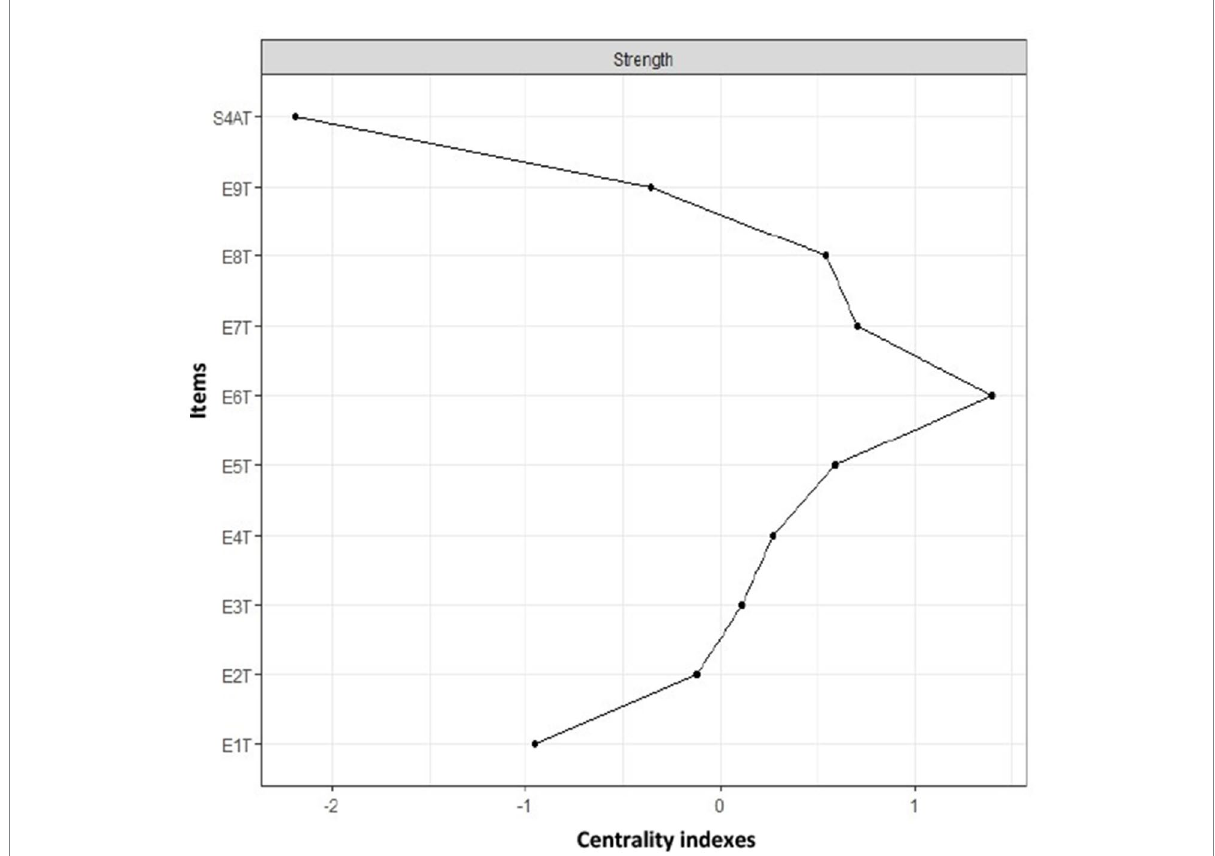
FIGURE 2 Network analysis strength centrality indexes of network analysis. Centrality refers to the measure with the highest number of connections along with the sum of the relationships it presents. T1: type 1; T2: type 2; T3: type 3; T4: type 4; T5: type 5; T6: type 6; T7: type 7; T8: type 8; T9: type 9; S4AT: healthy personality to psychosocial